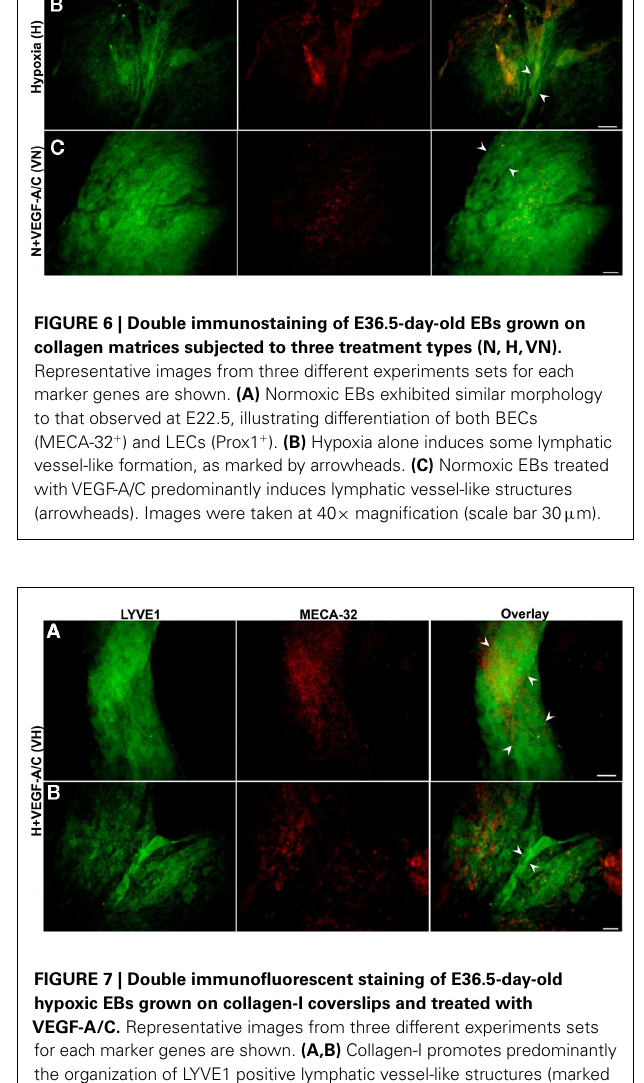
supported by Han et al. (2010), wherein they demonstrated that hypoxia can promote EB vascular development independent of VEGF. However hypoxia itself, in the absence or presence of few lymphatic vessel-like structures from EBs grown on collagen matrices, but no blood vessel structures at E36.5. This